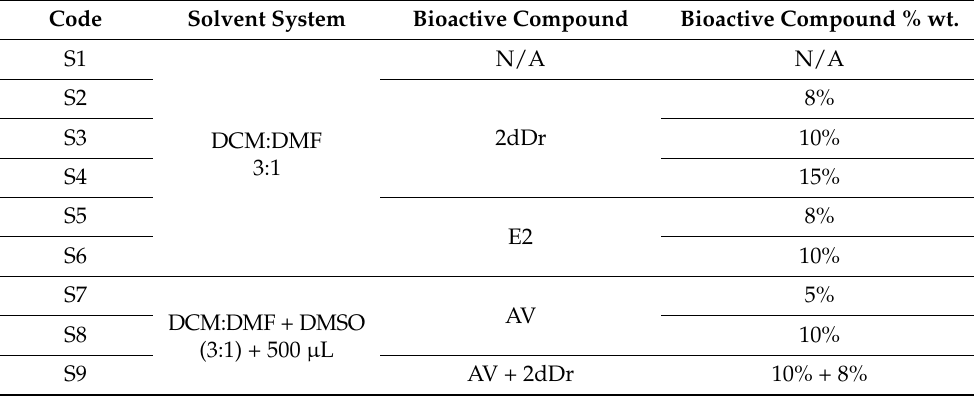
Table 1. PCL polymer solutions loaded with bioactive compounds.